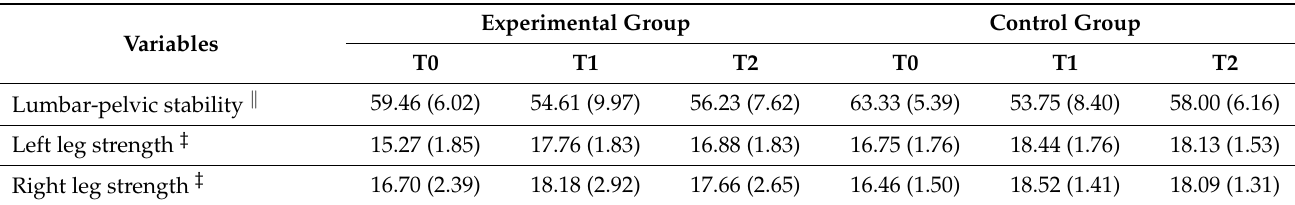
Table 2. Descriptive statistics (mean and standard deviation) of the study variables at baseline, posttreatment and follow-up